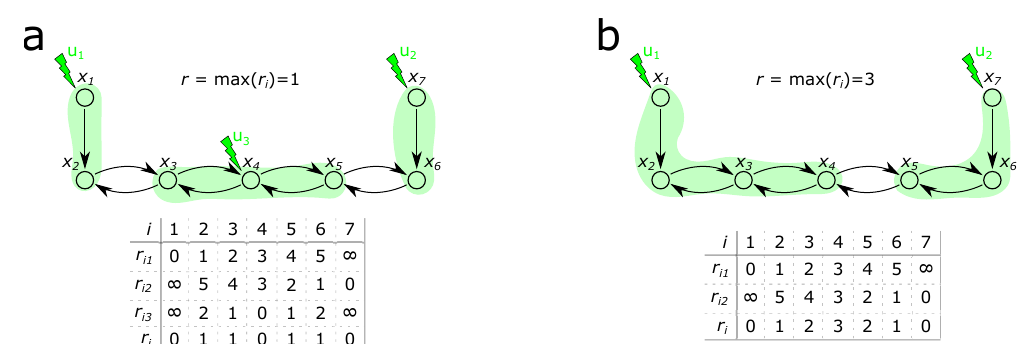
Figure 4. Visual representation of relative degree in the DAE-based network representation. ( a ) The relative degree is equal to one if three actuators were placed in the network, while ( b ) it is three if only two actuators were assigned to the